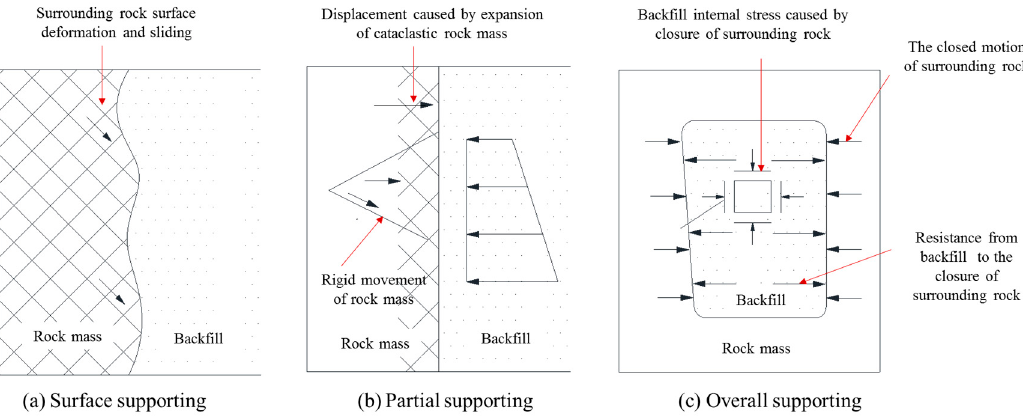
Figure 2. Action models of backfill supports in mines. ( a ) Surface supporting: backfill can prevent the progressive failure of surrounding rock mass under low stress condition, ( b ) Partial supporting: backfill produces local support force to the fracture zone and jointed rock mass, and ( c ) Overall supporting: as the backfill being compressed, the overall support force is generated, which plays the role of the overall support member in the underground mine structure.